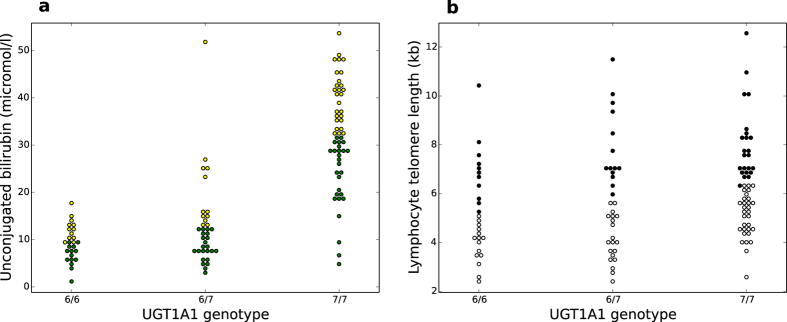
UGT1A1 genotypes and their influence on telomere length.(a) UCB concentration distribution according to genotype, P < 0.001, Kruskall-Wallis 1-way ANOVA. (b) Telomere length according to genotype P = 0.034, Kruskall-Wallis 1-way ANOVA.